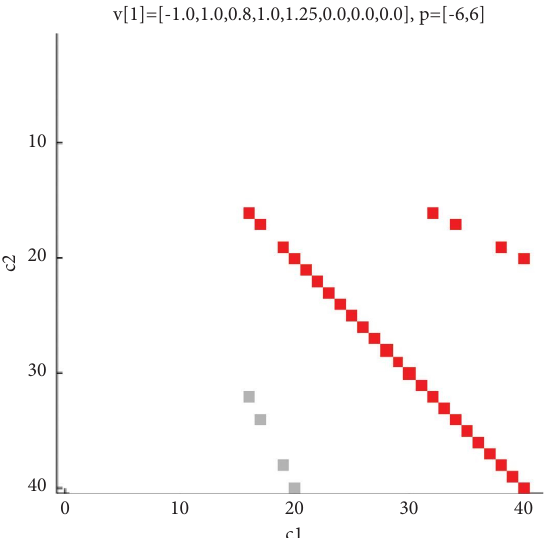
Figure 9: Simulation using full ftness tuple with values outside of the set − 1 , 0 , 1 { } generates periods longer than 12 for both species, and the species C has periods 32, 34, 38, 39, and 40, as observed in some species of long-period masting 1